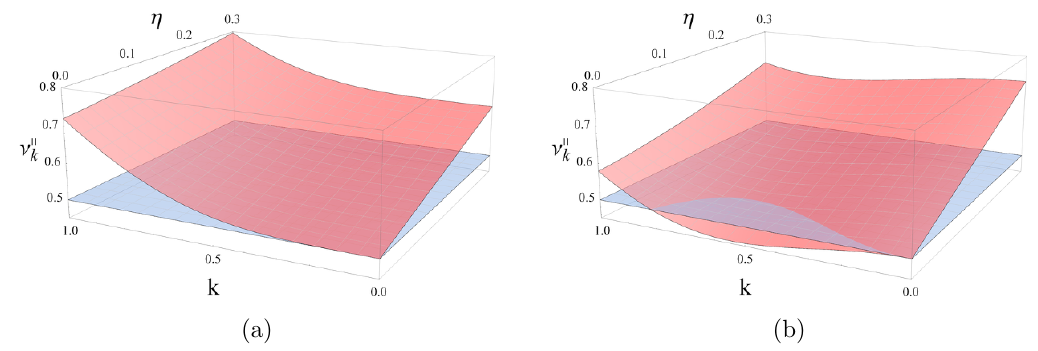
is plotted against k